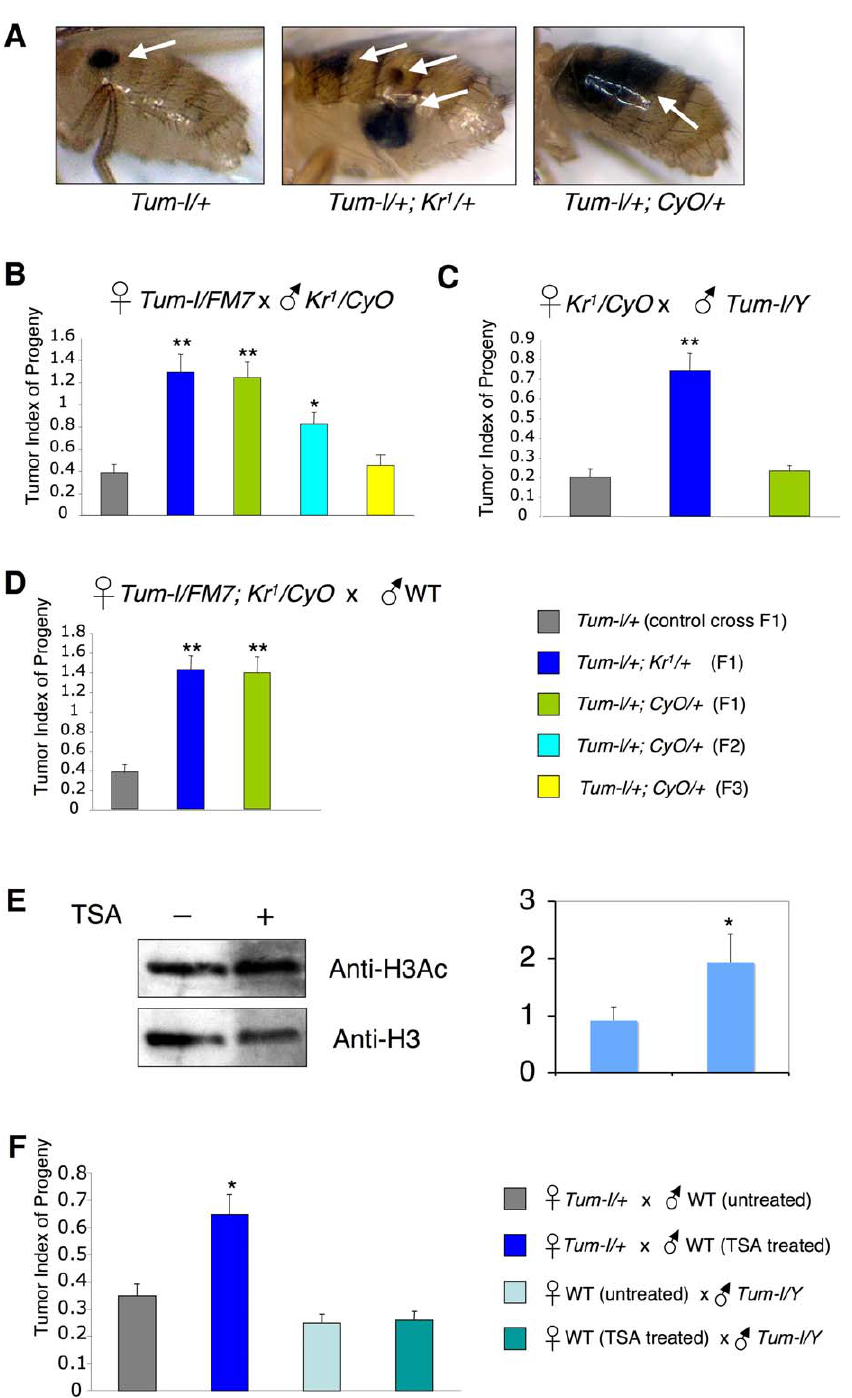
Figure 1. Epigenetic Enhancement of hop Tum-l Tumorigenicity by Kr 1 or TSA Treatment Requires Maternal hop Tum-l (A) Representative F1 progeny adult flies of indicated genotypes with blood tumors (black masses; arrows) in the abdomen are shown. The parents of these flies were hop Tum-l/ þ females and wild type males (left), or hop Tum-l/ þ females and Kr 1 /CyO males (center and right). (B–D) The tumor indices of progeny flies (genotypes are indicated in bottom right) are shown as mean and standard deviation of at least three independent crosses. ‘‘ Control cross F1 ’’ were from hop Tum-l/ þ crossed to wild type. Parental genotypes are indicated on the top. FM7 and CyO are marked balancer chromosomes for the X and second chromosomes carrying a wild-type copy of the hop and Kr genes, respectively. Note that when hop Tum-l was inherited from the mother (B, D), but not from the father (C), Kr 1 epigenetically enhanced hop Tum-l tumorigenicity. (E) Total protein extracts from adult flies raised on food containing 4.5 l M TSA were subjected to SDS-PAGE and blotted with anti-acetyl-H3. The membrane was stripped and reblotted with anti-H3 (full-length gel image is shown in Figure S1). Quantification of three independent blots is shown to the right. (F) Tumor indices of F1 progeny from wild-type flies treated or untreated (control) with TSA and hop Tum-l/ þ females or males as shown. The F1 were raised in the absence of TSA. Tumors were counted in F1 that inherited hop Tum-l . Note the parent-of-origin differential effects on the tumorigenesis of F1 flies. Three independent crosses with . 200 progeny from each cross were counted. *, p , 0.01; **, p , 0.001, Student’s t -test.